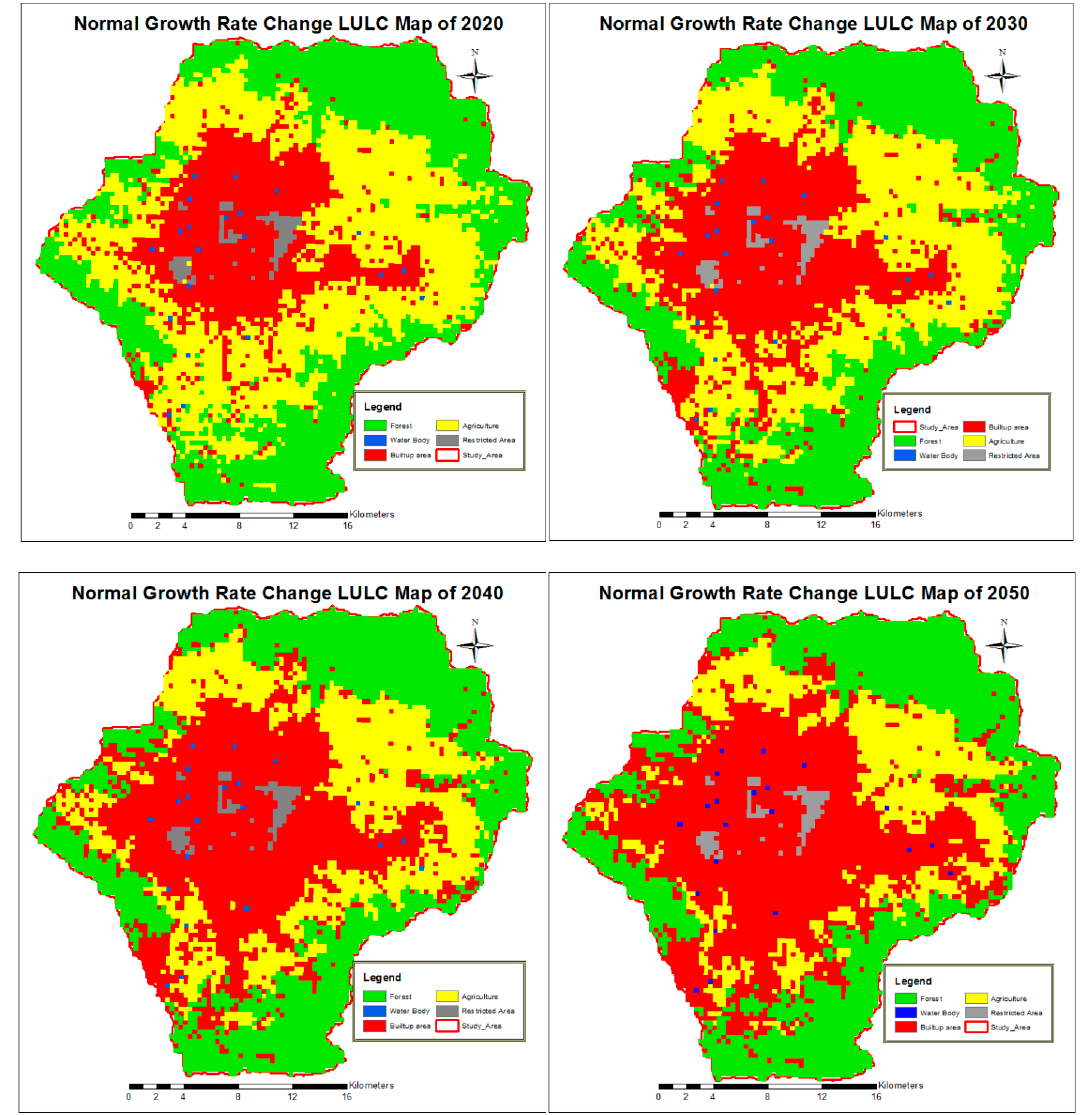
/ cover map for 2020–2050 (extracted from Figure 3. Projected future land use/cover map for 2020–2050 (extracted from [29]). Figure 3. Projected future land use